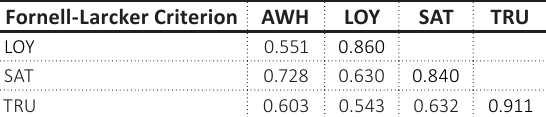
Table 3. Discriminant validity